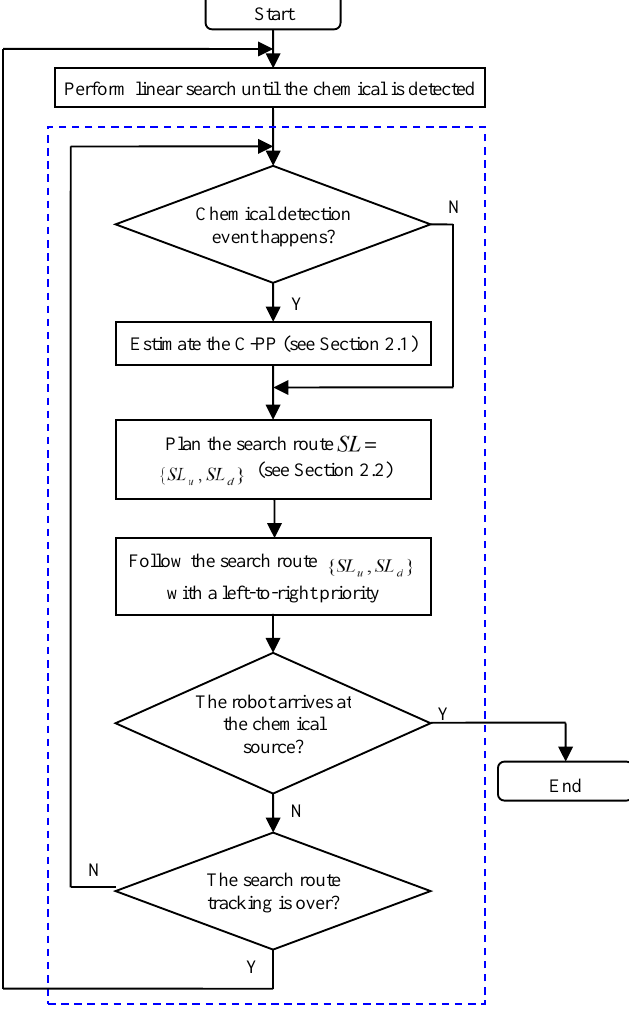
Figure 3. Framework of the CSS based on ERP method. The ERP procedure is represented by the steps enclosed within broken lines.